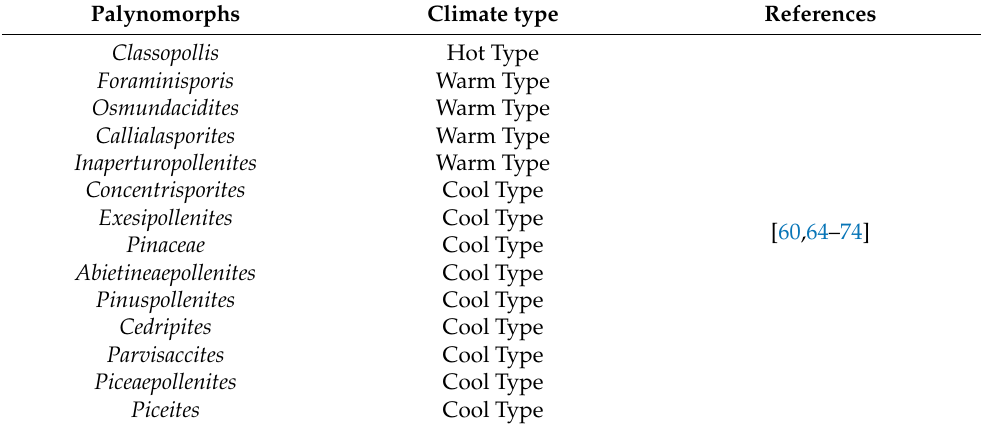
Table 3. Climate-types